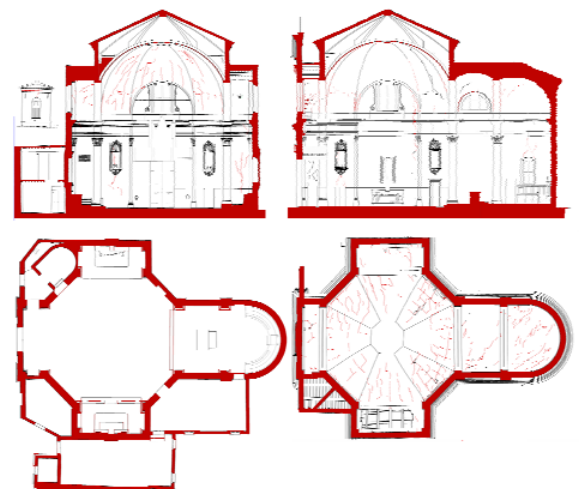
Figure 3: Church of Natività Beata Vergine Maria in Quatrelle. In the results of the survey stage, there are not only the geometric information, but also the description and localisation of cracks.